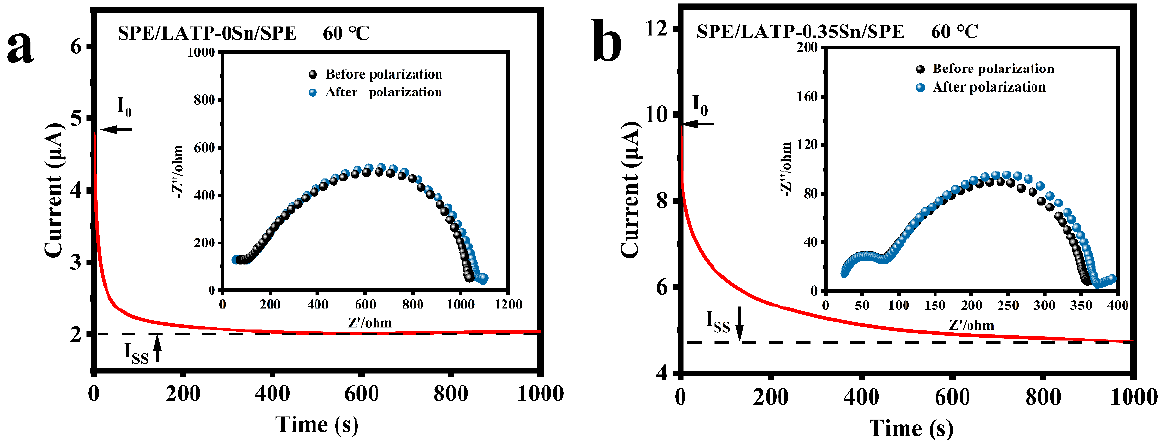
Figure 5. Impedance spectra and DC polarization for ( a ) SPE/LATP-0Sn/SPE and ( b ) SPE/LATP- 0.35Sn/SPE.